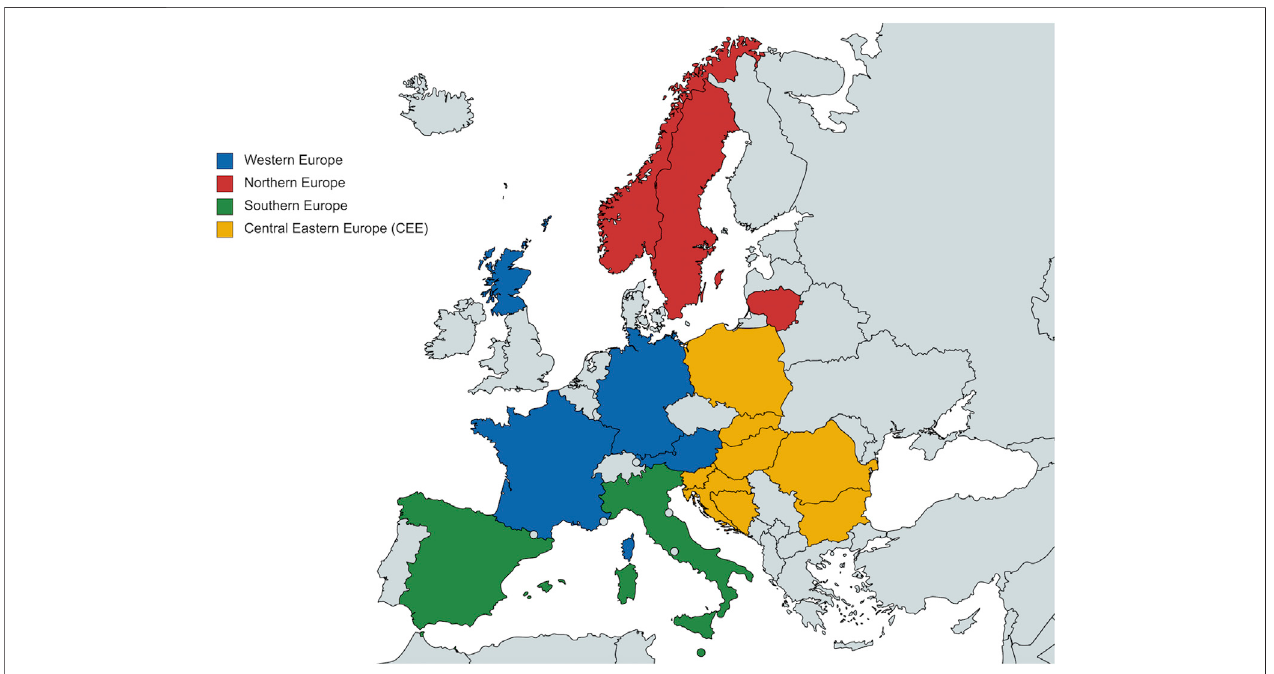
FIGURE 2 | Map of countries included in the survey according to geographical region as de fi ned by EU Vocabularies (European Commission, 2021). Map generated through MapChart (MapChart, 2021). It is important to note that Scotland and Catalonia are included in the study as independent entities from the respective countries (United Kingdom and Spain), with autonomous decision-making power including in the healthcare sector.